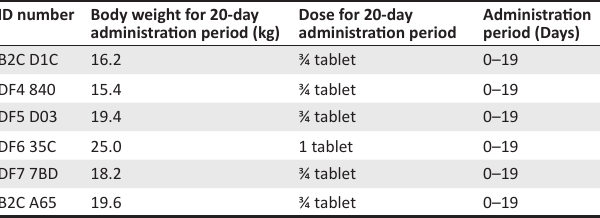
TABLE 2a: Study day (Day) and dose administered to each respective dog during the 20-day administration period.